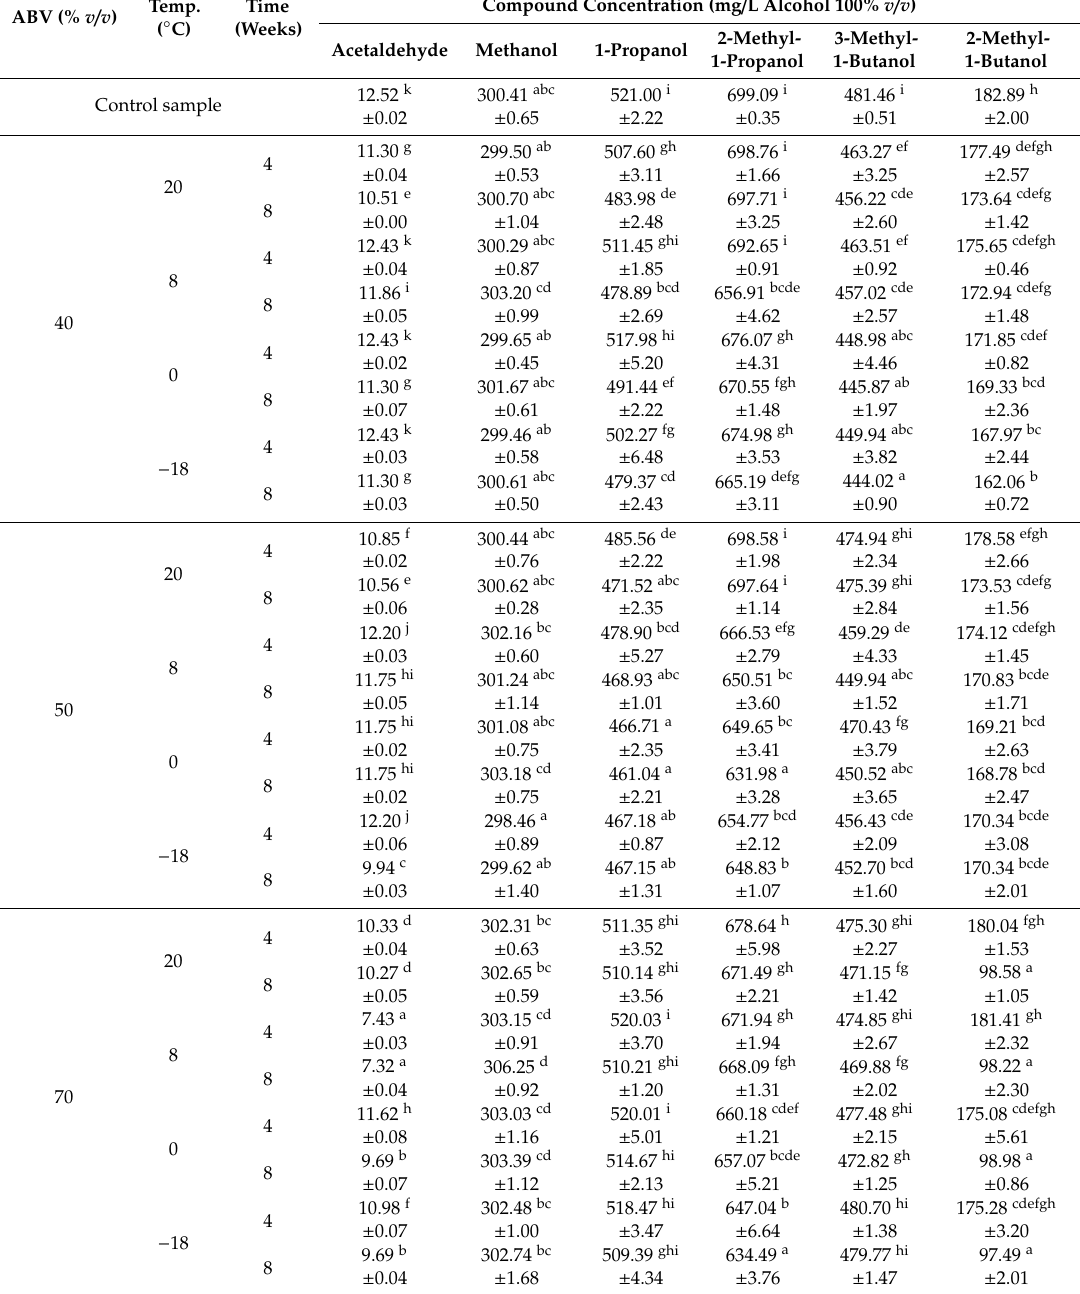
Table 2. Changes in aldehydes and alcohols in rye distillate samples during storage at di ff erent temperatures. Temp. ABV (% v / v ) ( ◦